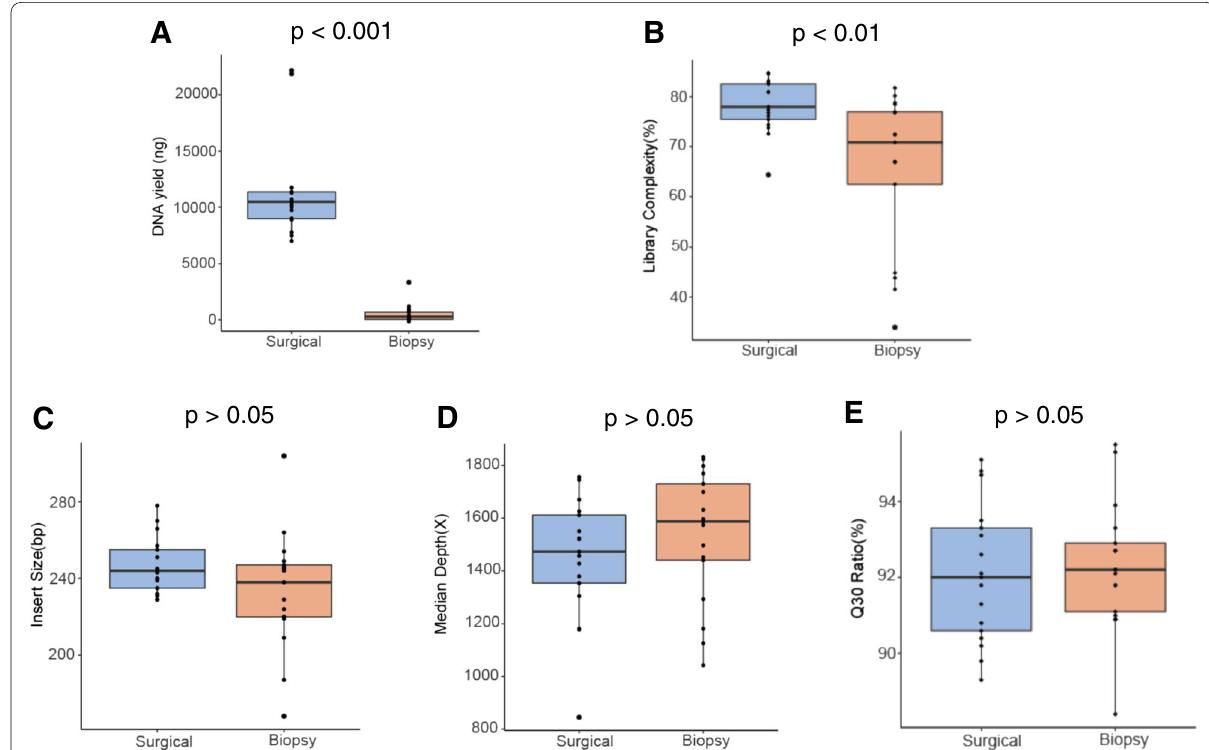
Fig. 2 Quality control measures of targeted next generation sequencing for biopsy and surgery. A DNA yield. B Library complexity. C Insert size. D Median depth. E Q30